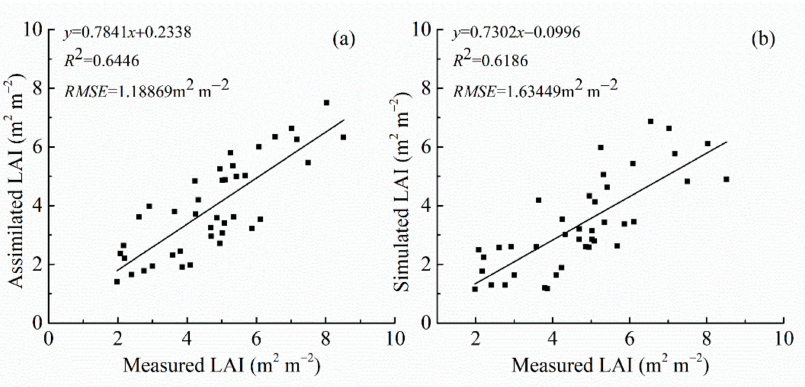
Figure 5. Linear regression analysis with measured LAI. ( a ) Assimilated LAI; ( b ) Simulated LAI.